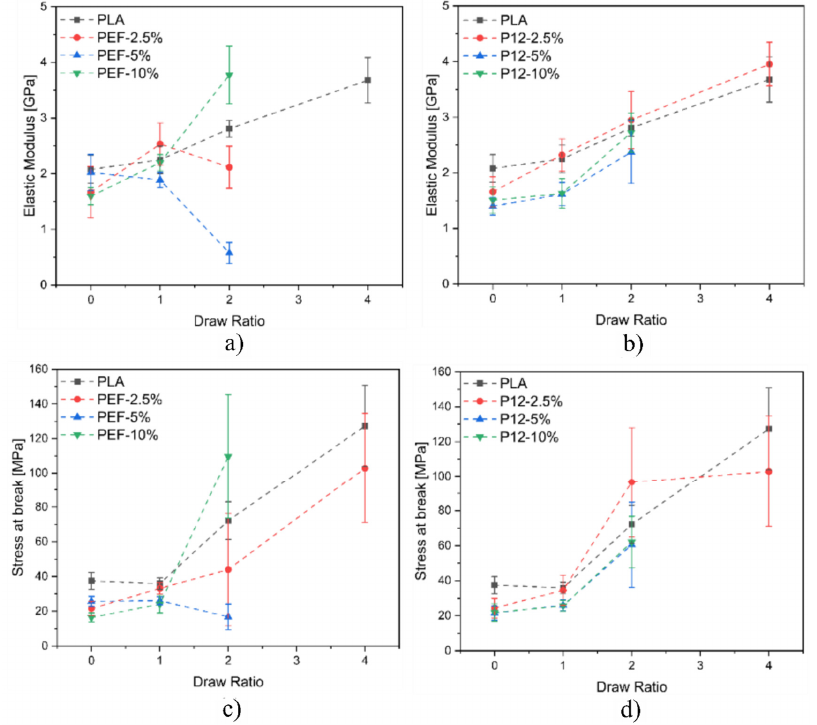
Figure 13. Plots of the elastic modulus as a function of the draw ratio ( a ) PLA/PEF and ( b ) PLA/PDoF fiber blends, and plot of stress at break as a function of the draw ratio ( c ) PLA/PEF and ( d ) PLA/PDoF fiber blends.